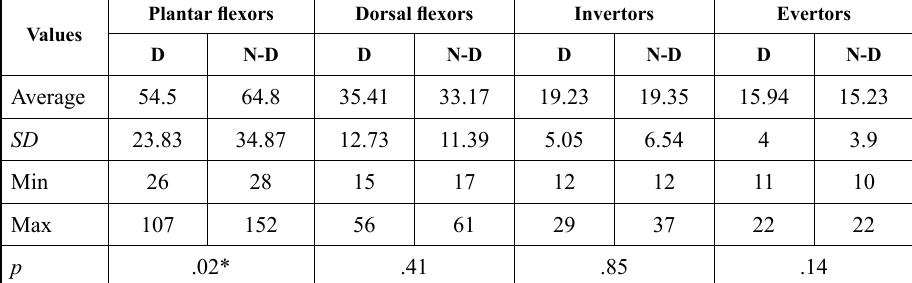
Note. * p < .05, Wilcoxon Signed Ranks